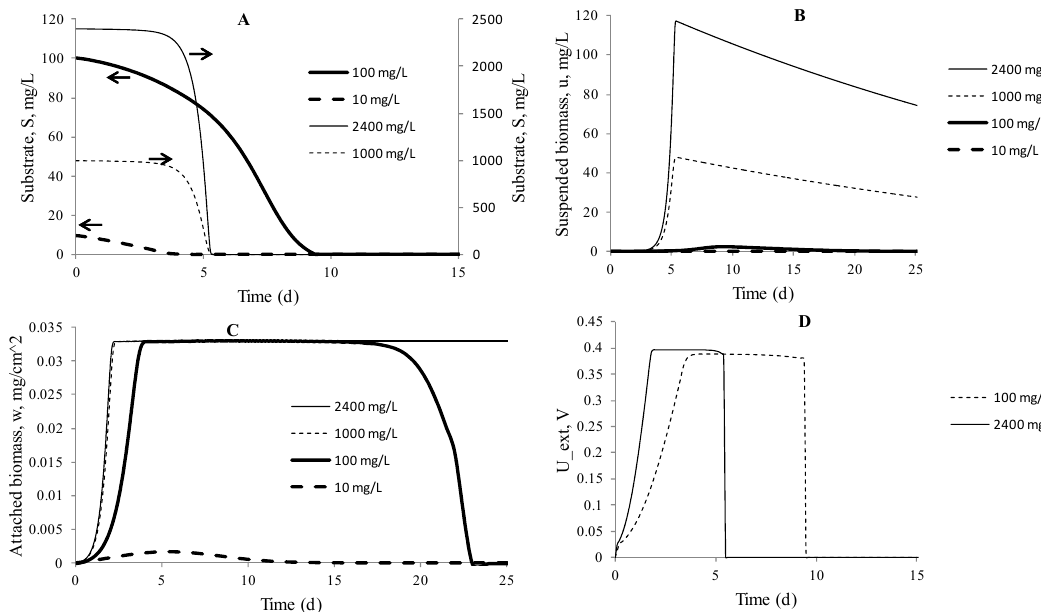
Figure 3. Simulated time-course profiles of process variables at different initial substrate concentration. ( A ) the substrate concentration; ( B ) suspended biomass concentration; ( C ) attached biomass concentration, and ( D ) the external voltage U ext .